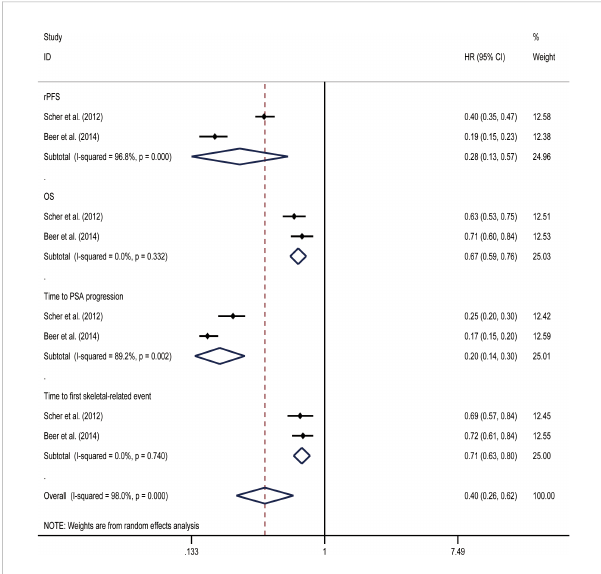
FIGURE 7 Results of a direct meta-analysis on the mCRPC